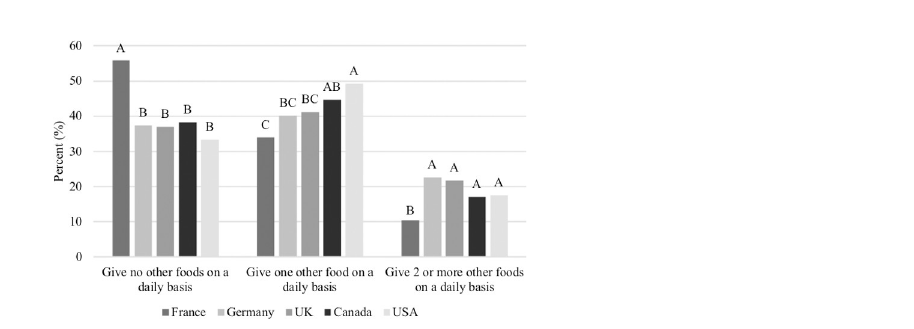
Fig 3. Amount of other foods (respondents had the options of dog treats, table scraps, fruits/vegetables and other foods) given on a daily basis among respondents in each country (n = 3,298). Proportions in the same category that do not share a common letter are significantly different at P < 0.05.